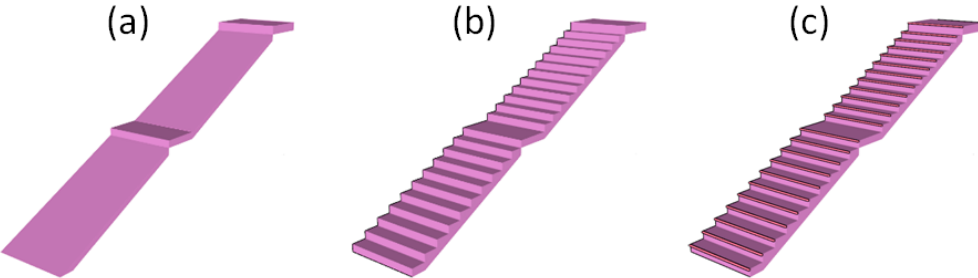
Figure 7. Different geometrical representations for stair in ( a ) ILoD2; ( b ) ILoD3; and ( c ) ILoD4.